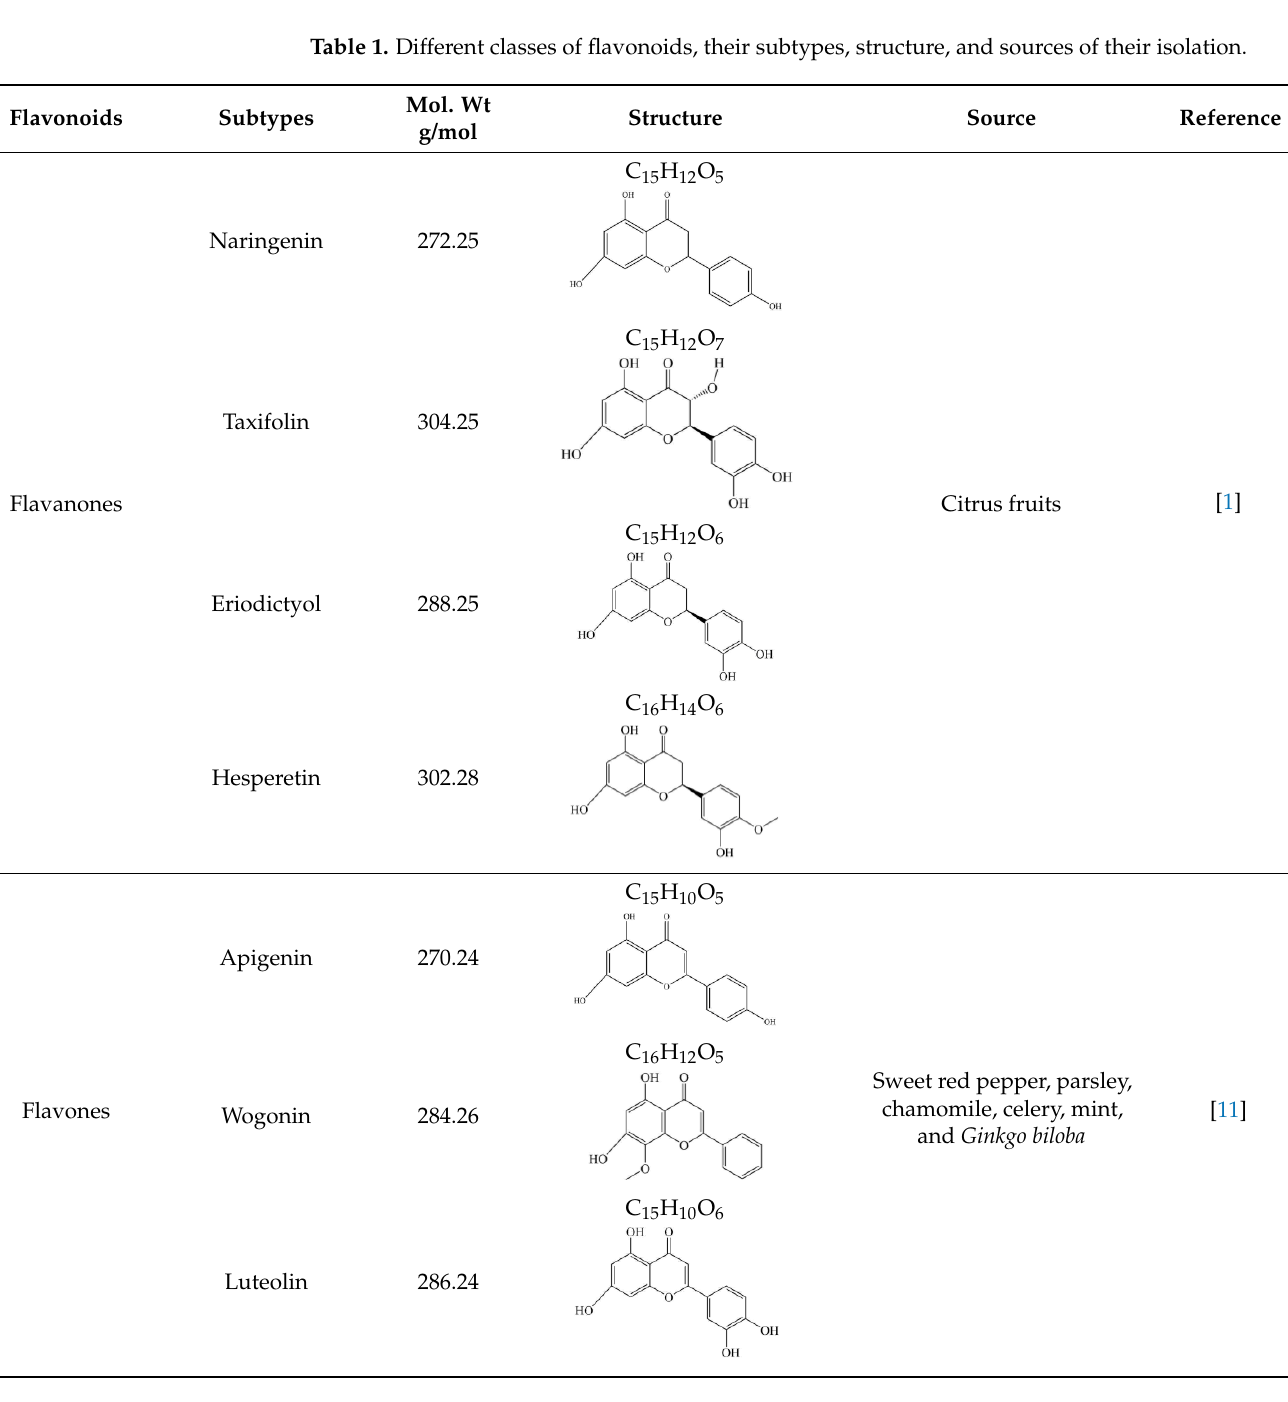
Figure 2. Major inflammatory pathways targeted by flavonoids.